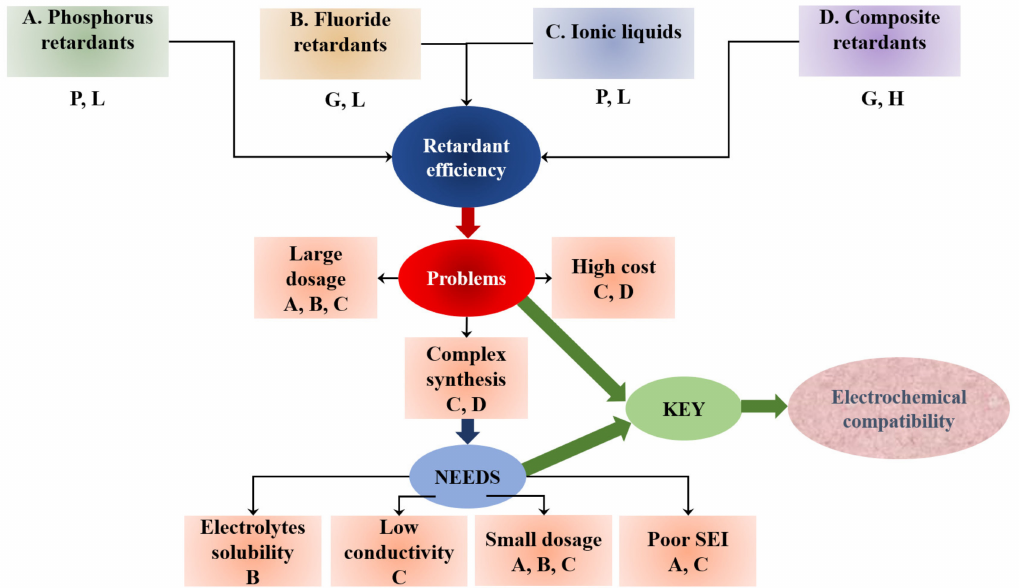
Figure 9. Summary selection of various electrolyte retardant additives, where A, B, C, and D mean the type of flame retardant used. P—poor electrochemical compatibility, G—good electrochemical compatibility, L—low retardant efficiency, H—high retardant